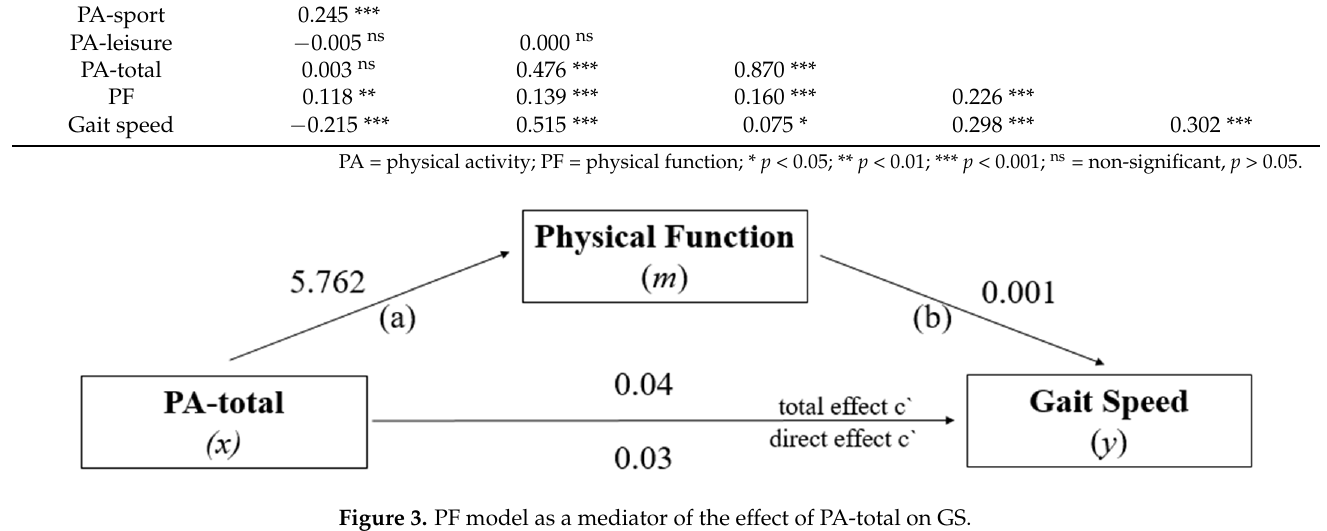
Figure 3. PF model as a mediator of the effect of PA-total on GS.